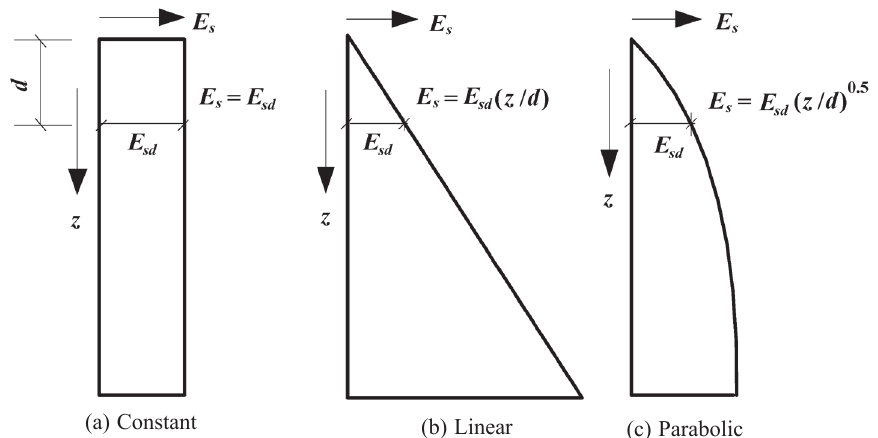
Fig. 2. Three idealized soil profiles considered: a) constant, b) linear and c) parabolic (Gazetas